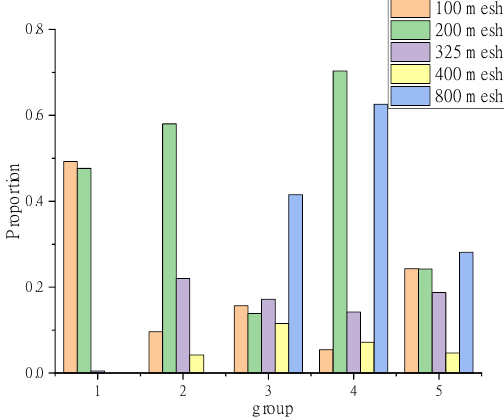
Figure 8. Percentage of each sand mesh.